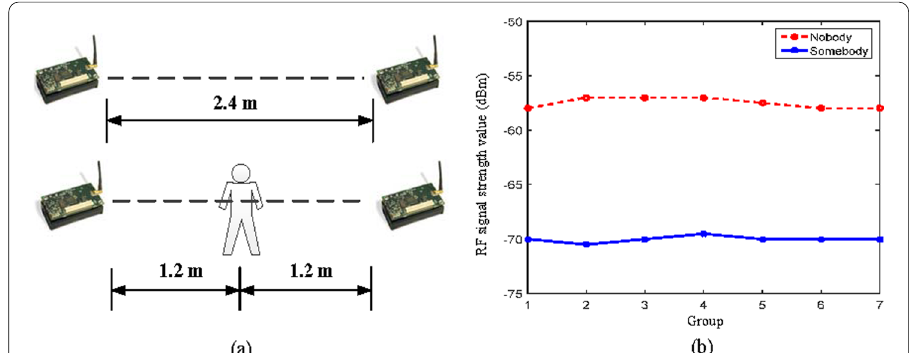
Fig. 2 Influence of human body on received signal strength. a Experimental setup and b comparison of RSS values